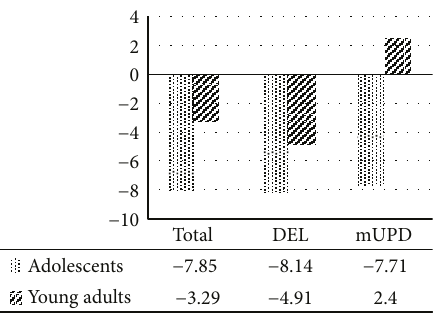
Figure 1: Di ff erence between PARS total score and the cut-o ff value based on normative